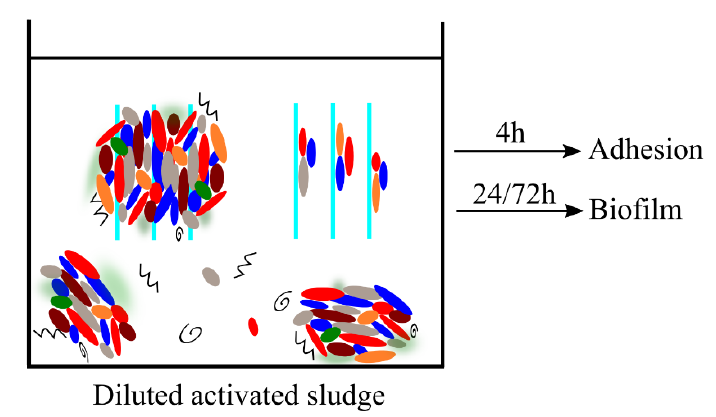
Figure 1. Schematic diagram of the system for testing the adhesion process with activated sludge.